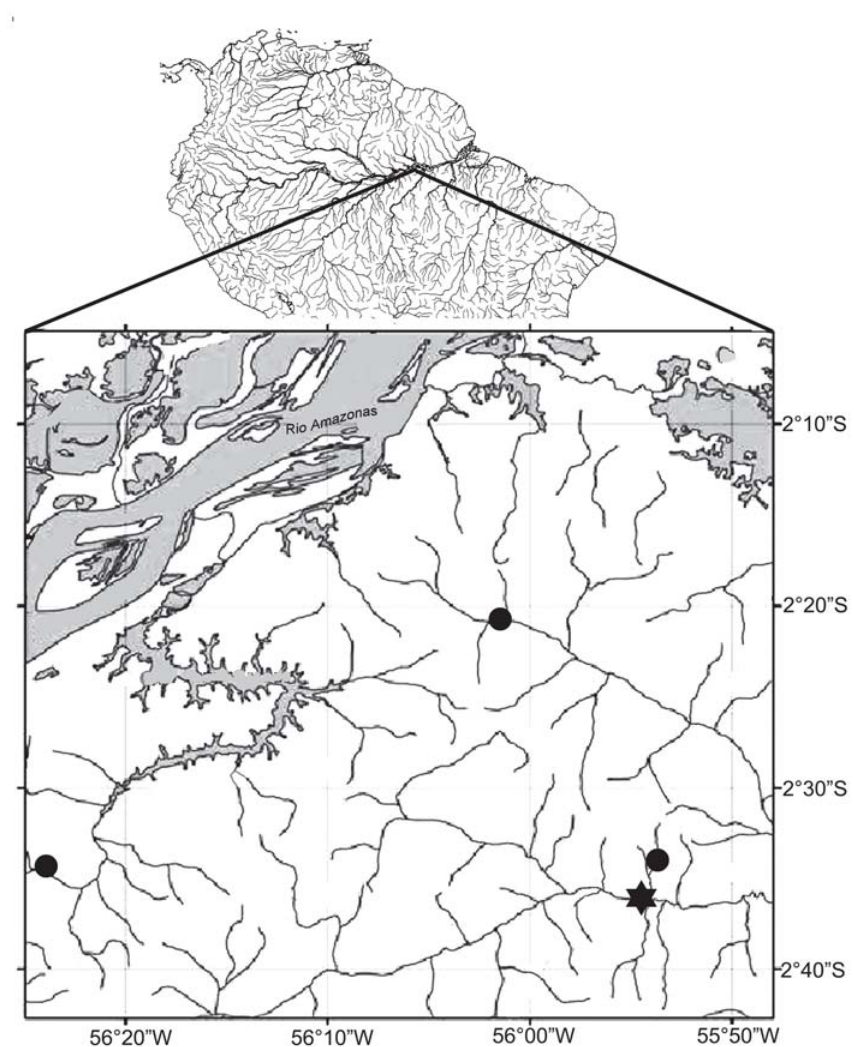
Fig. 5. Map of northern South America, showing (inset) the surroundings of Juruti, Pará State, Brazil, and sites of collection of Hemigrammus arua (dots). Star: Type